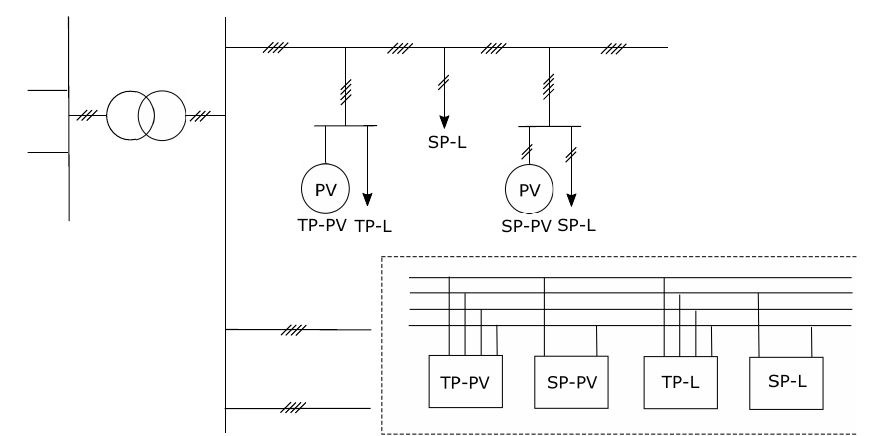
Figure 1. Schema of a common European low-voltage (LV)